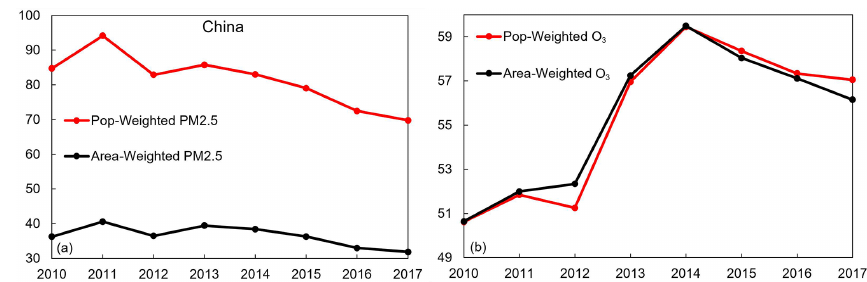
Figure 1. National population-weighted (pop-weighted) and area-weighted annual PM 2 . 5 (a) and MDA8 O 3 (b) from 2010 to 2017 from our base model simulation (CEDS_MEIC). The units are micrograms per cubic meter (µgm − 3 ) for PM 2 . 5 and parts per billion volume (ppbv) for ozone.